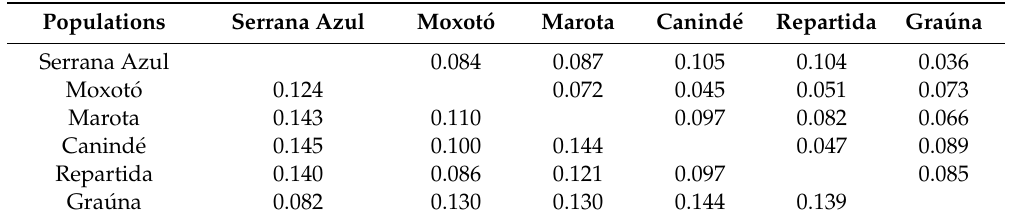
Table 2. Matrix of genetic distance DA between pairs of Brazilian breeds (below diagonal) and F ST between pairs of populations (above